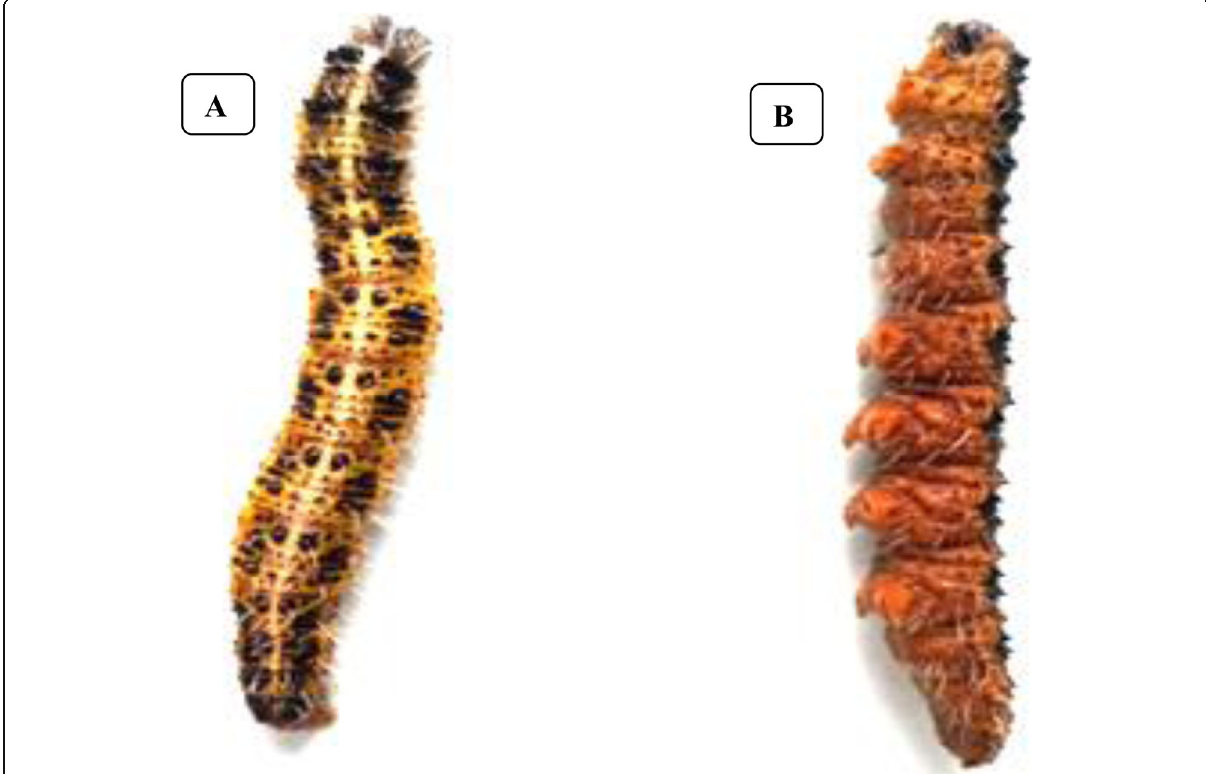
Fig. 1 Dead larvae of cabbage butterfly, Pieris brassicae a killed by Steinernema species, b killed by Heterorhabditis